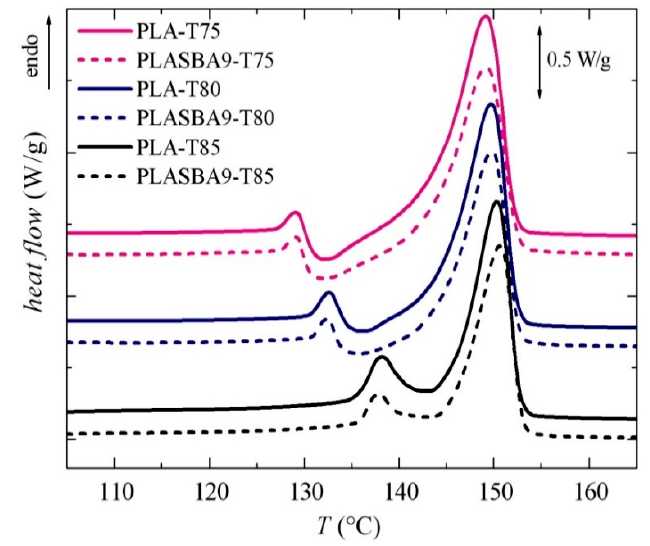
Figure 10. DSC melting curves after crystallization for 8 h from the glassy state at the indicated temperatures for the pristine PLA and its composite PLA-SBA9.